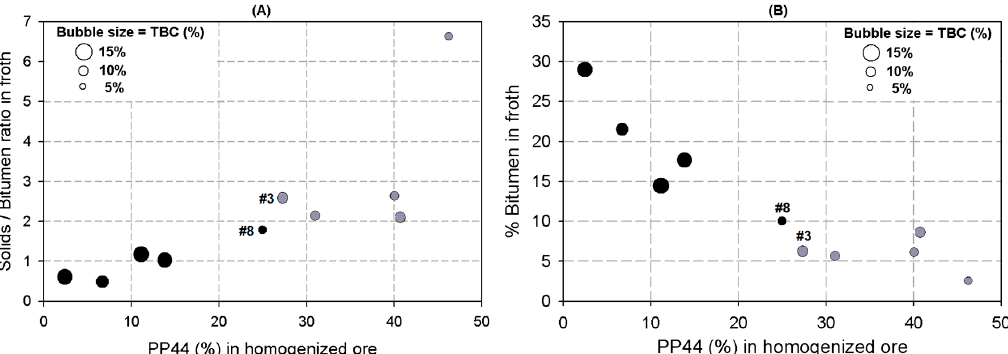
Figure 6. Scatterplots of solids/bitumen ratio and %bitumen in froth versus pp44 (%) in ore ( A , B ). Black circles = samples with dark froth; grey circles = samples with brown froth. Bubble size relates to percentage of total bitumen content (%TBC).